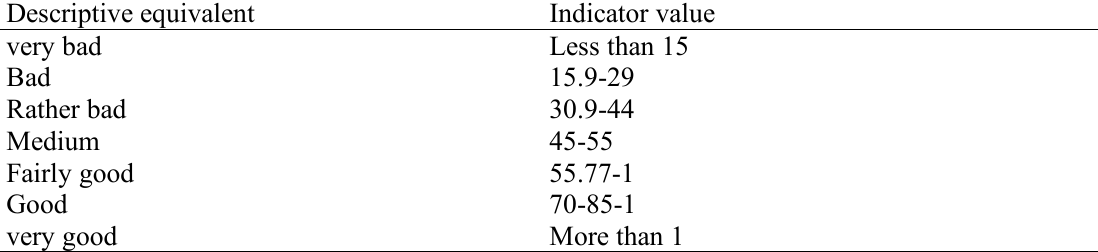
Table 5 - Determination of descriptive index equivalent